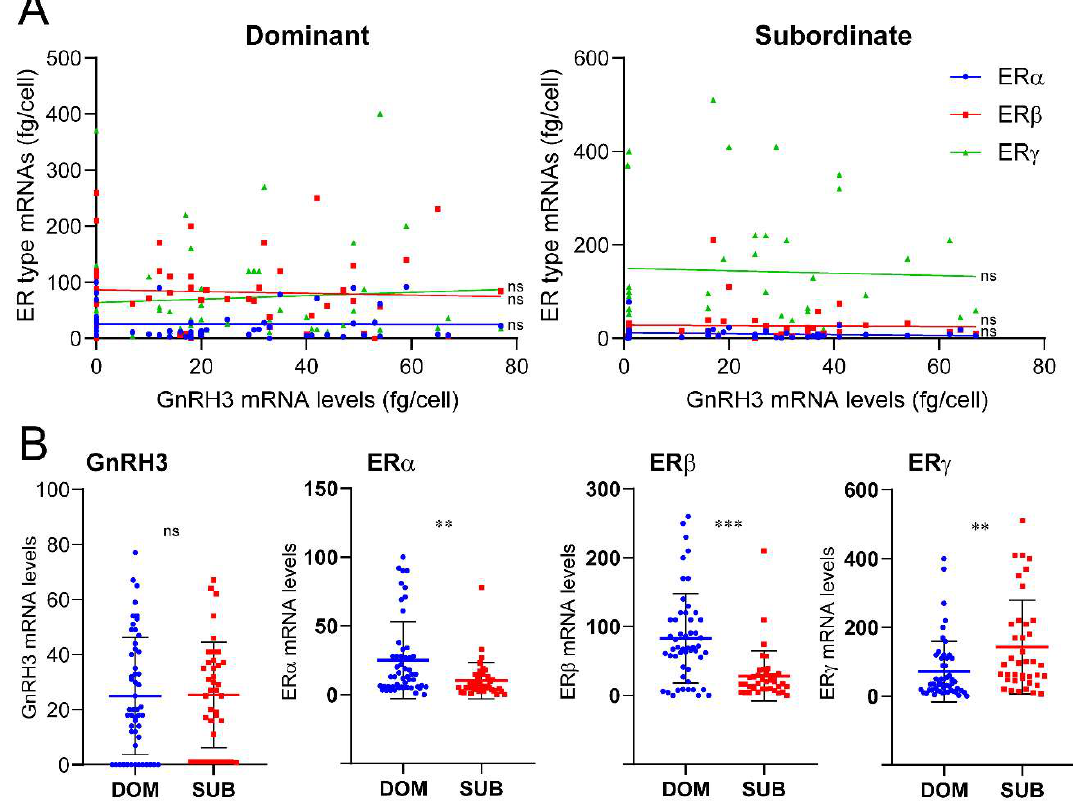
Figure 6. Expression of ER genes in GnRH3 neurons in dominant and subordinate male tilapia. ( A ) Graphs showing the expression of ERα (blue dots), ERβ (red dots) and ERγ (green dots) mRNA levels in individual cells in dominant and subordinate males. The X-and Y-axes represent the absolute mRNA levels (fg/cell) of GnRH3 and ER types in individual GnRH3 cells, respectively. ( B ) Scatter blot graphs showing mRNA levels of GnRH3, and ERα-γ in single GnRH3 cells in dominant (DOM, blue dots) and subordinate (SUB, red dost) males. Correlation of GnRH3 and ER types mRNA levels were examined by Pearson’s r, while the mean difference of GnRH3 and ER types mRNA levels between DOM and SUB were analyzed by an unpaired t test. p values: ** p < 0.01, *** p < 0.001; ns, nonsignificant.